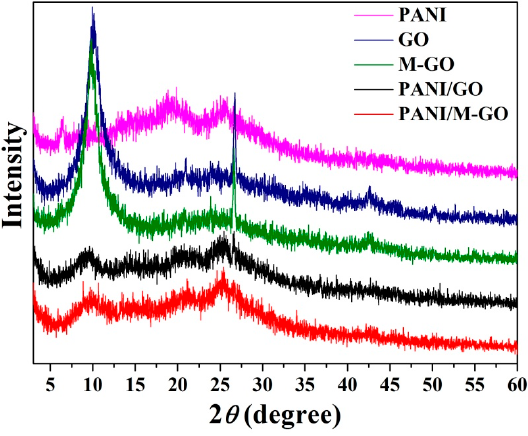
Figure 9. X-ray diffraction (XRD) patterns of PANI, GO, M-GO, PANI/GO, and PANI/M-GO composites.